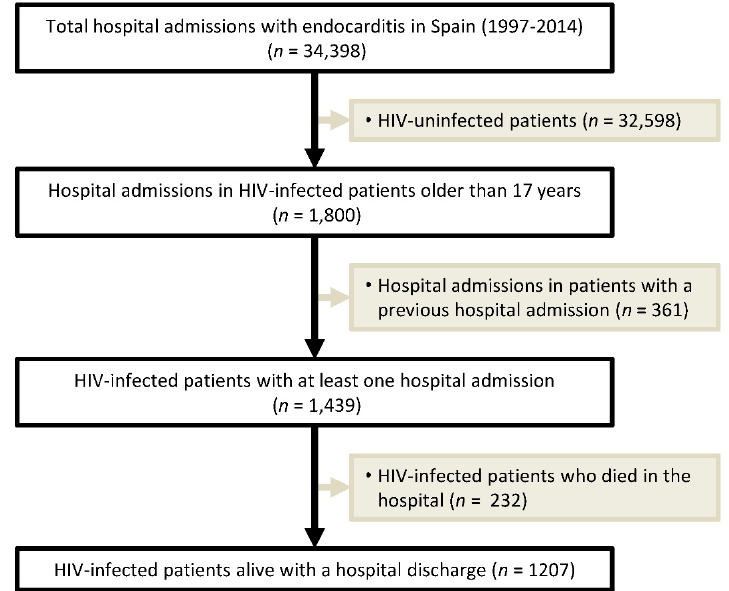
Figure 1. Flow chart of the selection of human immunodeficiency virus (HIV)-infected patients in Spain included in the study (1997 to 2014).